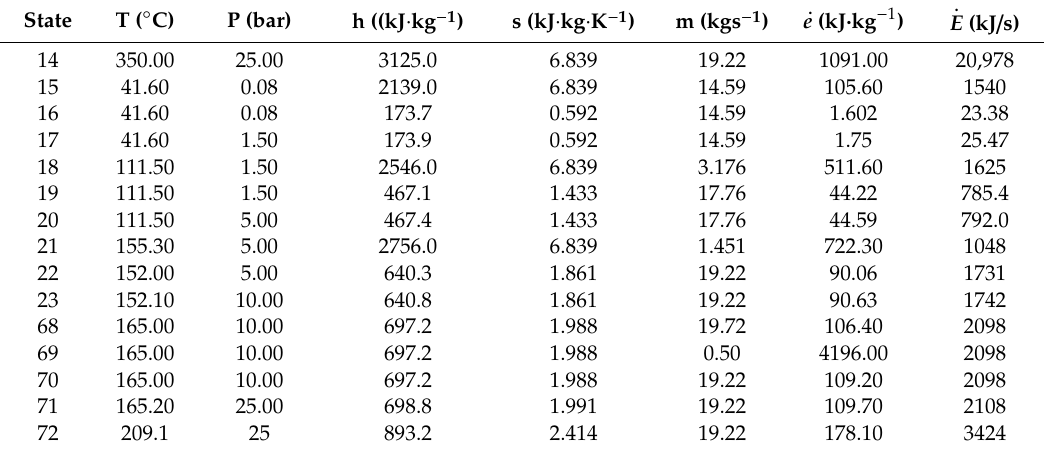
Table A2. Thermodynamic state points properties for the steam turbine in the IMP.